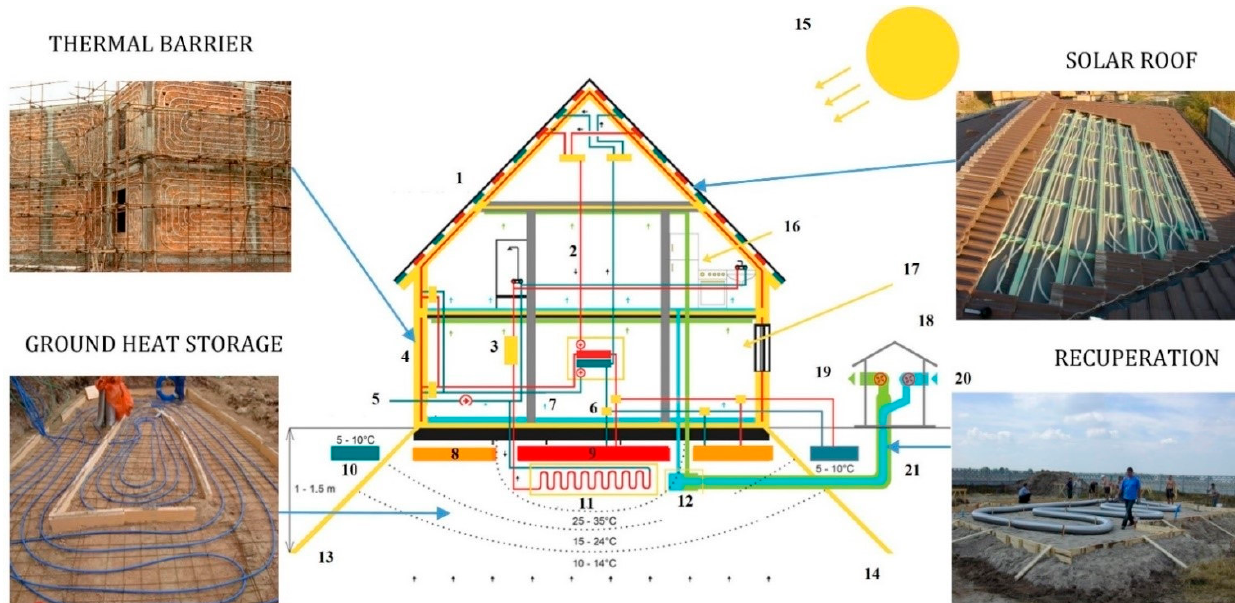
Figure 1. Scheme of ISOMAX system operation. 1—energy (solar) roof; 2—exhaust air from the in-